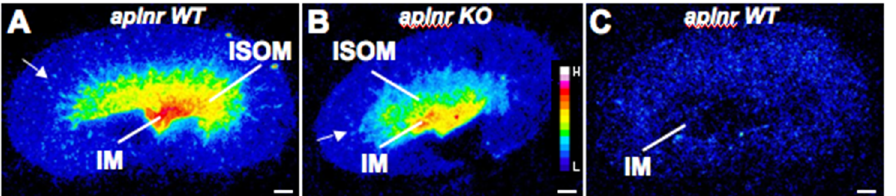
Fig 4. Autoradiographic film images of ISHH with antisense- apela probes in kidneys from adult male aplnr wildtype (WT) (A,C) and knockout (KO)(B) mice. As in the rat kidney, apela labellingin the mouse kidney is mainly locatedin the inner medulla(IM) with weaker labellingin the inner stripe of the outer medulla (ISOM). There is also weak, scattered labellingin the cortex (arrowed).Background sense apela probe labellingis shown in ( C ), where the image contrast was increasedin Image J to show the outline of the tissue. Pseudocolour scale bar is shown in ( B ). The sectionswere exposedto film for 5 weeks and images were processedas in Fig 3. Scale bar = 500 μ m.